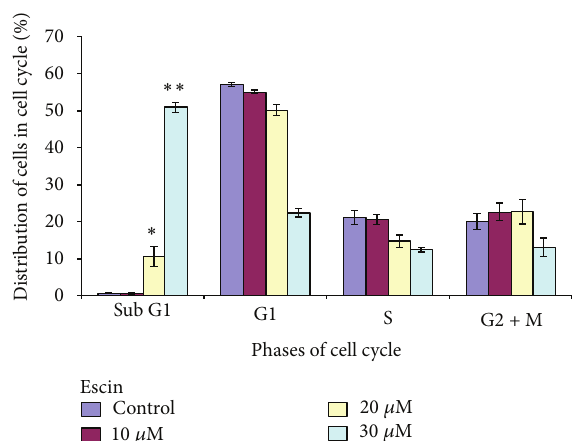
Figure 2: Effect of Escin on the distribution of Panc-1 cells in the cell cycle. The samples of the cells treated for 24 hours with various Escin concentrations were prepared and stained by propidium iodide immediately before flow cytometry analysis. The difference between the nontreated and treated cells in the induction of apoptosis was significant. ∗ 𝑃 < 0.05 and ∗∗ 𝑃 < 0.01 .